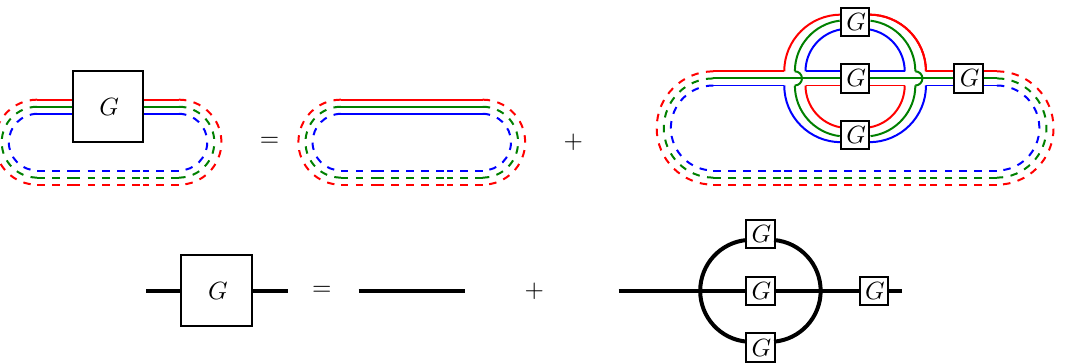
Figure 7. Schiwinger-Dyson equation for two point function: strand & single